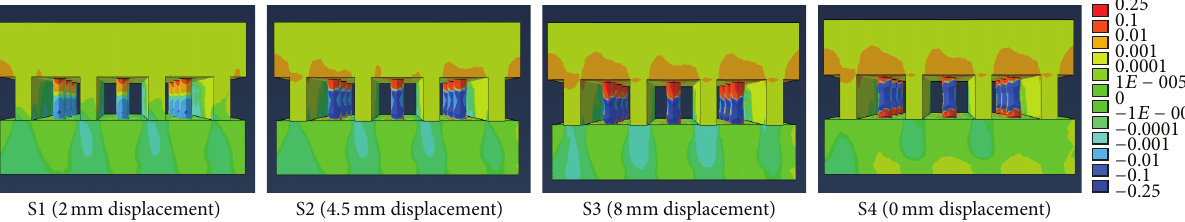
Figure 16: Axial strain component (LE22) contours distributed over the STE-0.10 model according to individual loading steps (Unit: